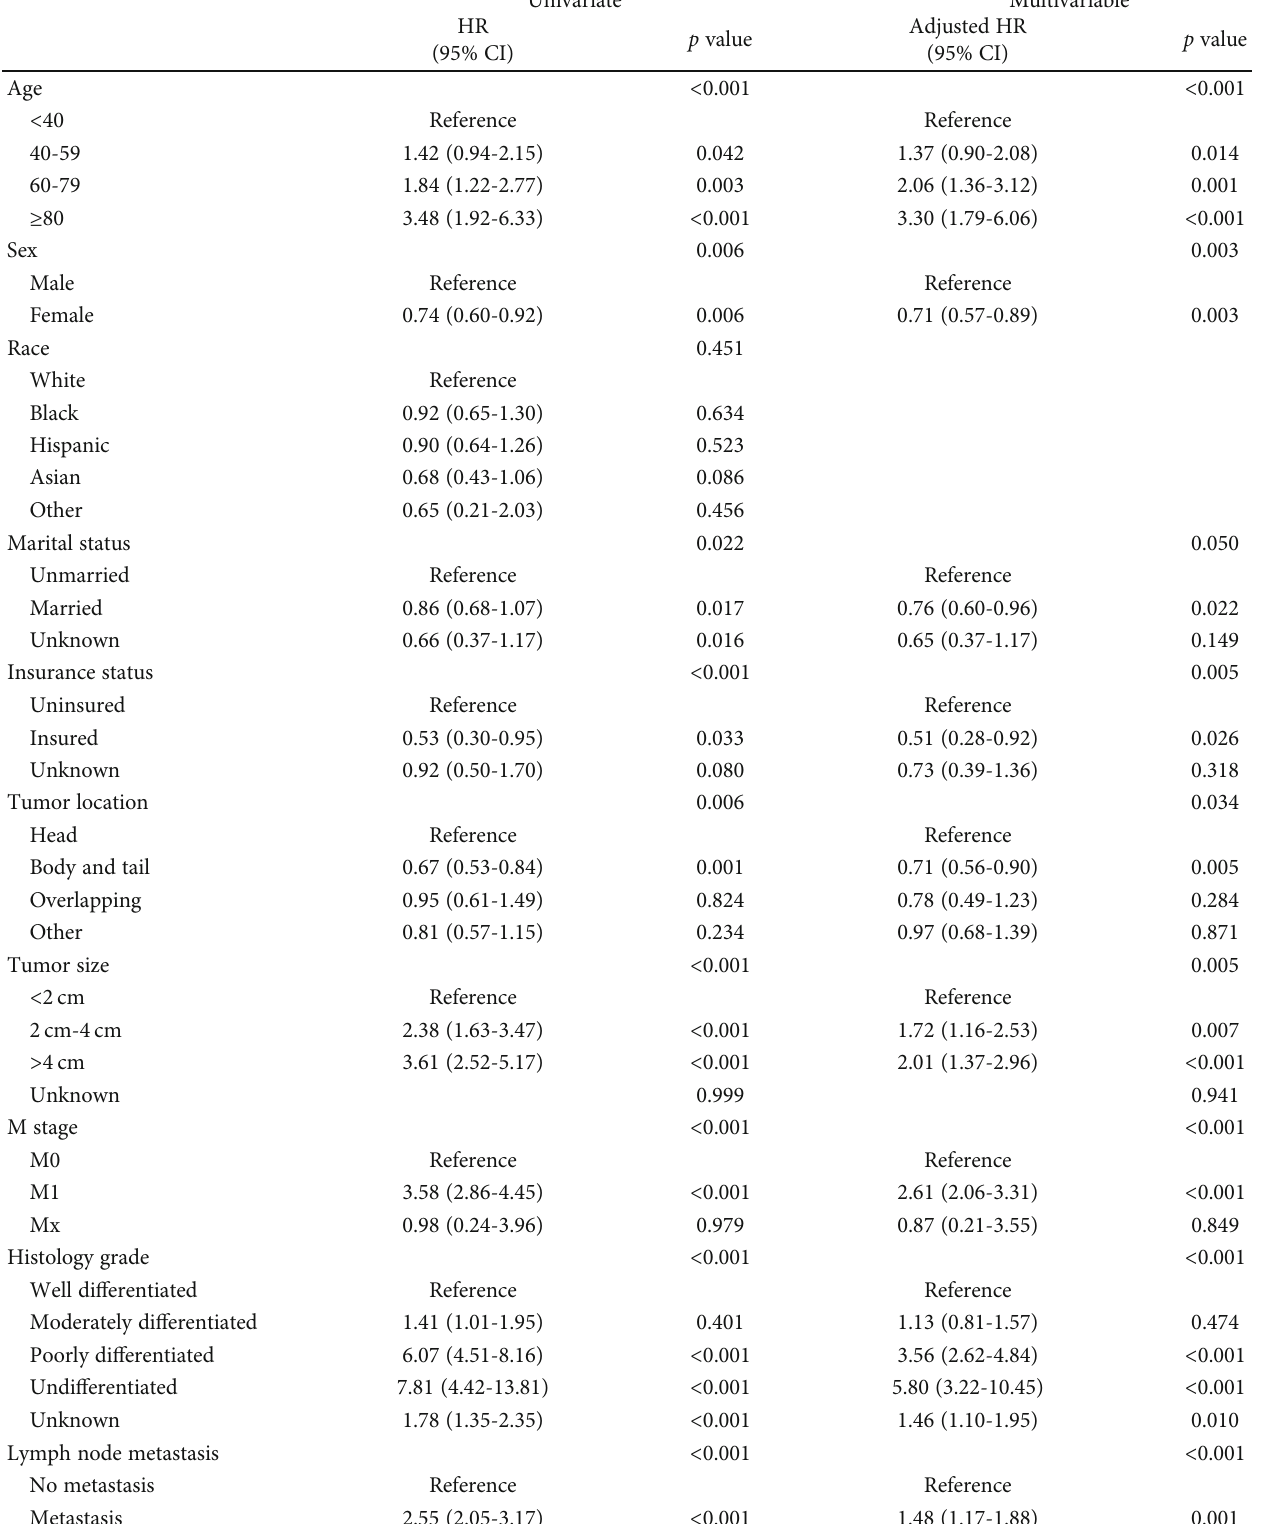
Table 3: Results of univariate and multivariable analysis for overall survival in the entire study